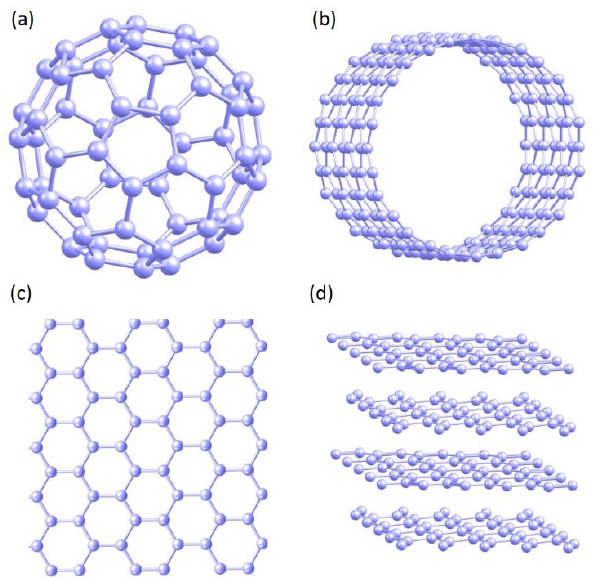
Figure 1. ( a ) Zero-dimensional Fullerene, ( b ) one-dimensional carbon nanotube ( c ) two-dimensional graphene and ( d ) three-dimensional graphite.